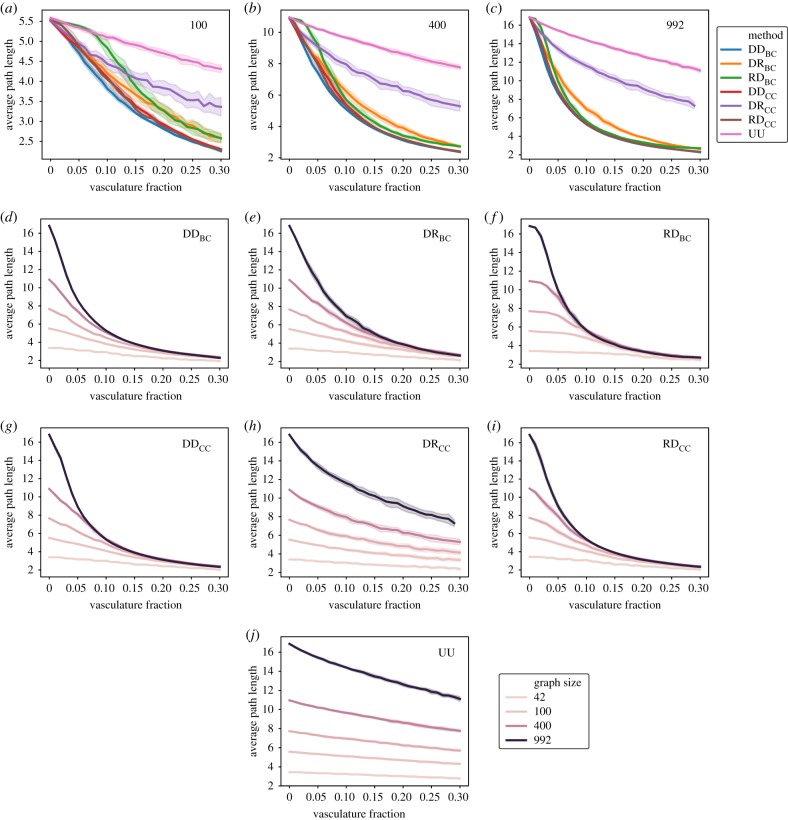
Average path length scaling for an increasing fraction of cells converted to vasculature in noisy 2D hexagonal lattices. Comparison between the different methods described in the Methods section (a–c). For graphs of constant size (a) 100, (b) 400 and (c) 992, the effect of node fusion following the high betweenness (DDBC), roulette wheel then highest value betweenness (RDBC), highest value then roulette wheel betweenness (DRBC), high closeness (DDCC), roulette wheel then highest value closeness (RDCC), highest value then roulette wheel closeness (DRCC) and random methods (UU). Scaling for each of the methods in different graph sizes (d–j). Exploration of the methods DDBC (d), DRBC (e), RDBC (f), DDCC (g), DRCC (h), RDCC (i) and R (j) in graphs ranging from 42 to 992 nodes. All data points contain 25 replicates; shaded regions represent a standard deviation of the sample.